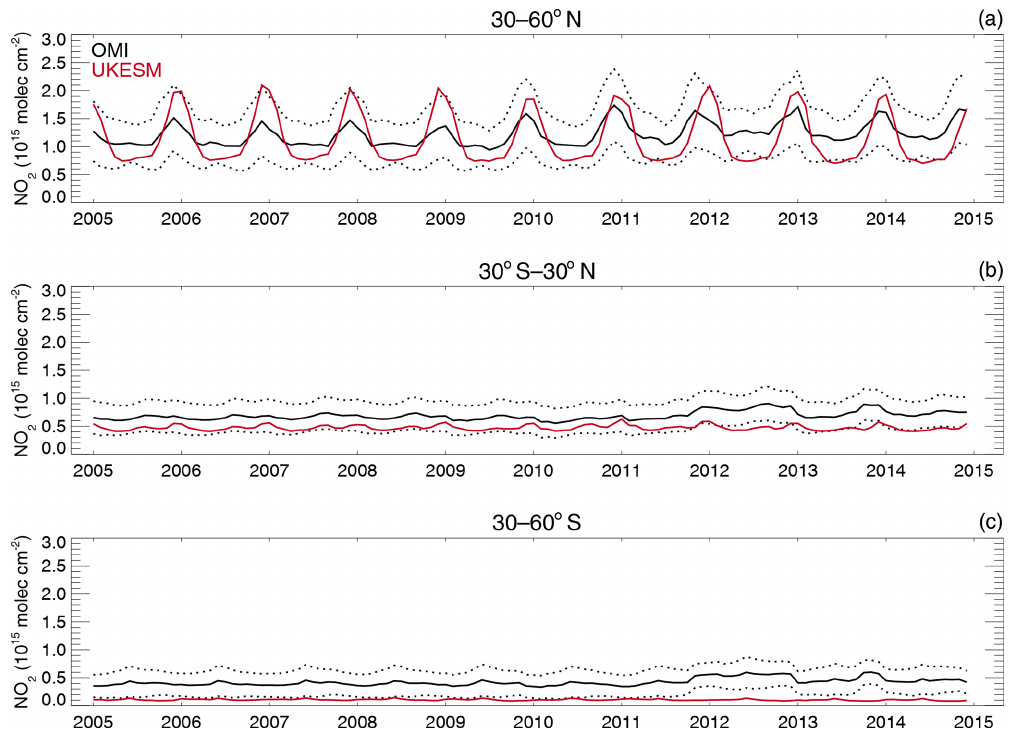
Figure 19. Tropospheric column NO 2 (10 15 moleculescm − 2 ) zonal time series (30–60 ◦ N – a , 30 ◦ N–30 ◦ S – b , 30–60 ◦ S – c ) for the ND simulation (red) and MOPITT (black). Dashed lines represent the satellite uncertainty